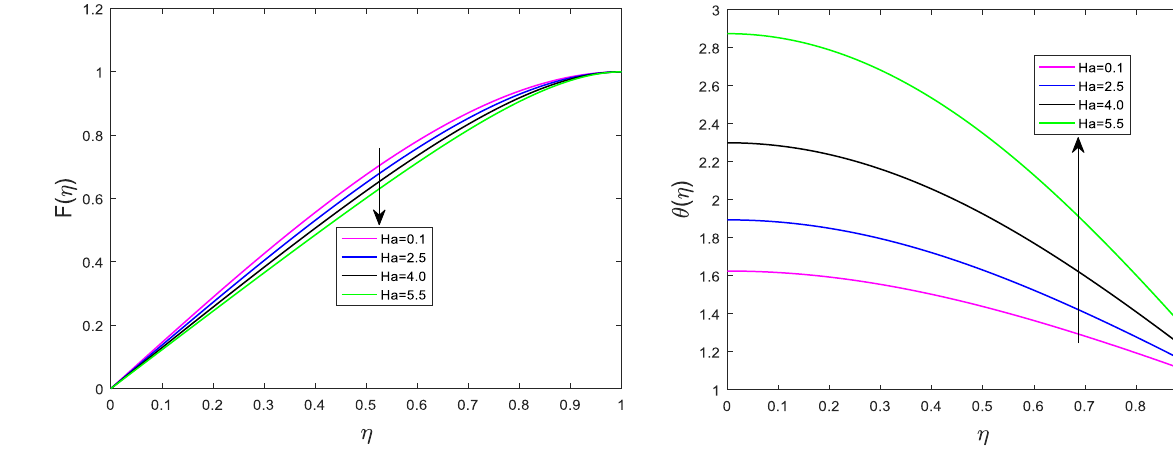
Figure 10: Effect of Ha on F ( η ) for fixed S = 0.6, β = 5.0, N t = Kr = 0.1, Ω T = 0.5, Ω C = 1.5, Ec = 0.1, N b = 2.0, Pr = 0.7 and Sc = 0.7